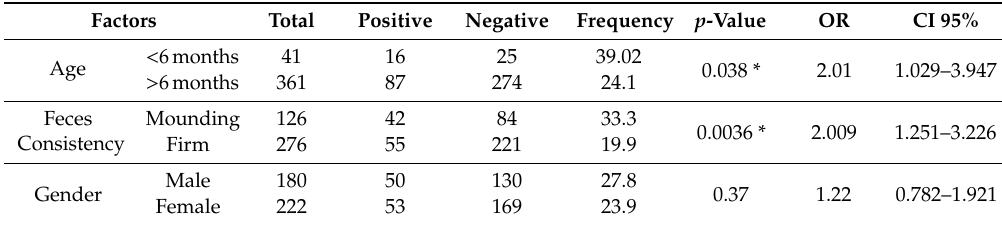
Table 1. Sample distribution and statistical analysis for the association of risk factors (age, feces consistency and gender).